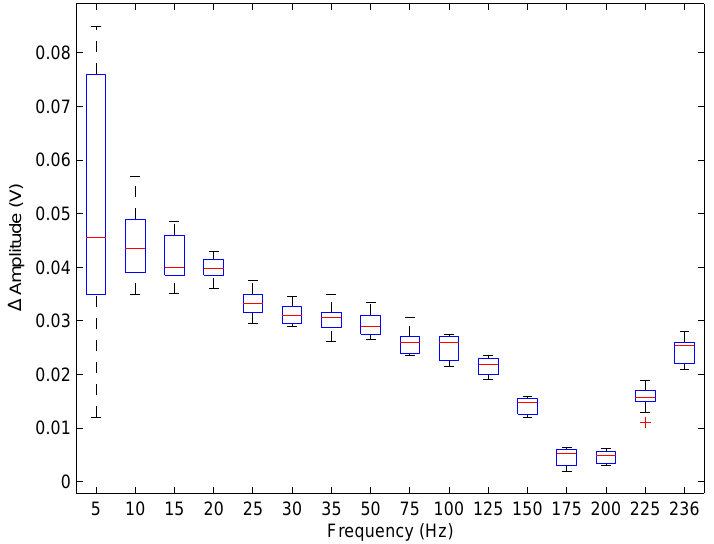
Figure 10. Box plot of voltage amplitude to the excitation frequency of the fabricated sensor. Minimum standard deviation in terms of voltage amplitude of sensor output is 0.0012 V at 200 Hz. Due to the coin-based stimulator, the sensor does not perform as well at lower